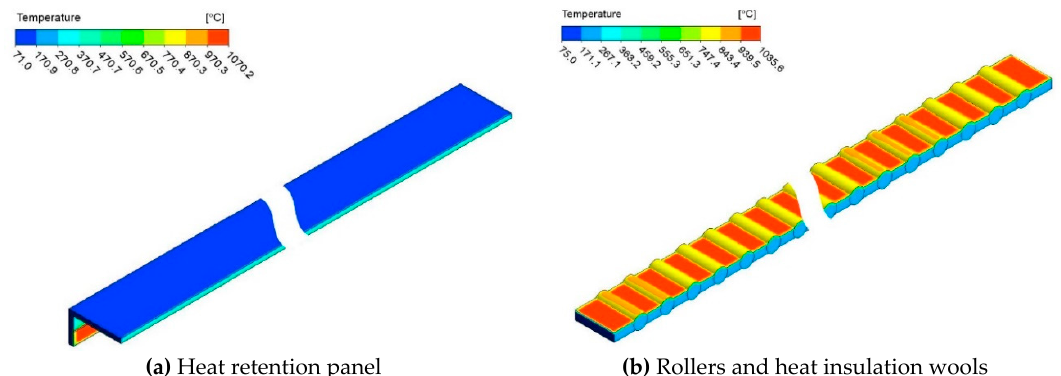
(a) Heat retention panel (b) Rollers and heat insulation wools Figure 13. Temperature contours of the acting-type heat retention panel model (Case 1) (local view). 294